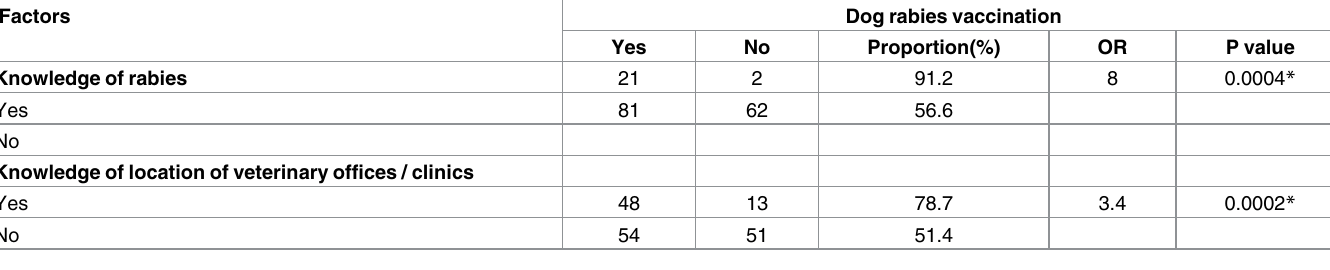
Table 2. Knowledge factors associatedto dog rabies